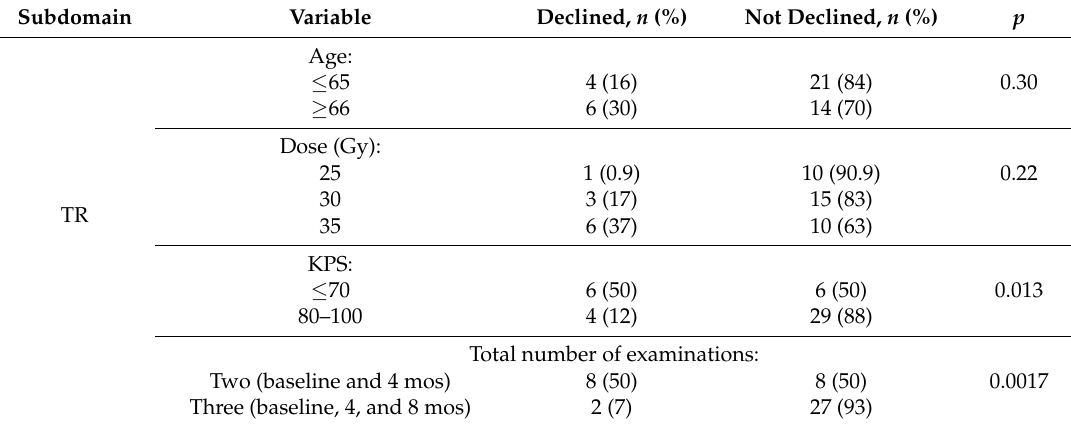
Table 5. Significant decline in four-month individual HVLT-R scores and associated